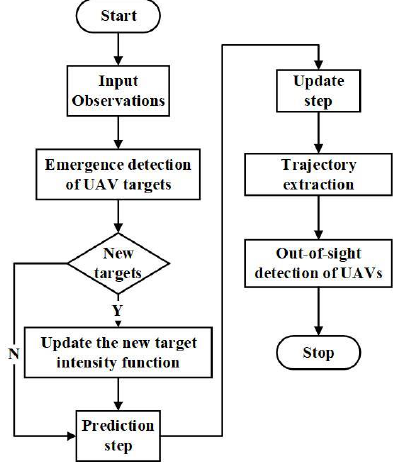
Figure 3. Flow chart of proposed multitarget tracking algorithm.